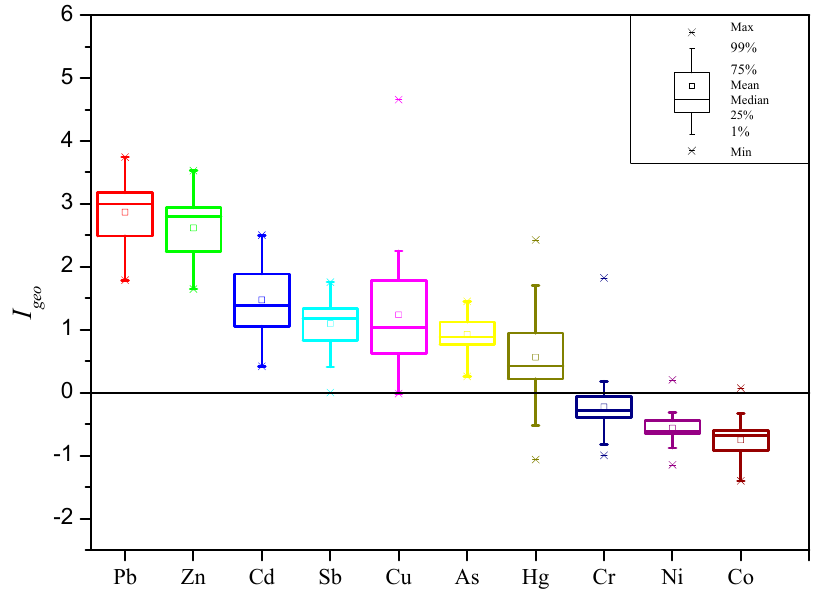
Figure 2. Box plot of geo-accumulation index value ( I geo ) of trace metal(loid)s in street dust of Hezhang